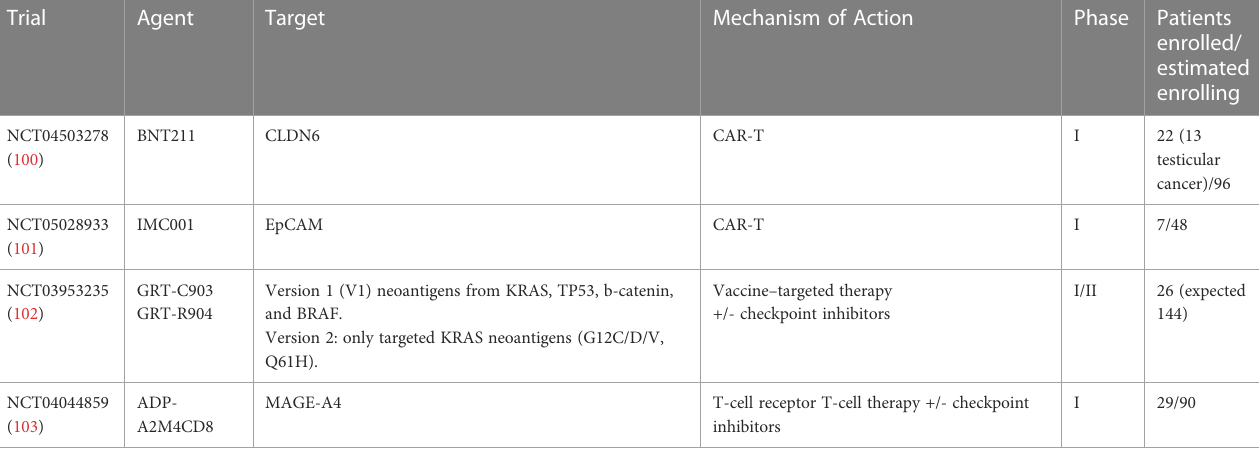
TABLE 2 Ongoing clinical trials with adaptive cell therapies on solid tumors presented at ESMO 2022.